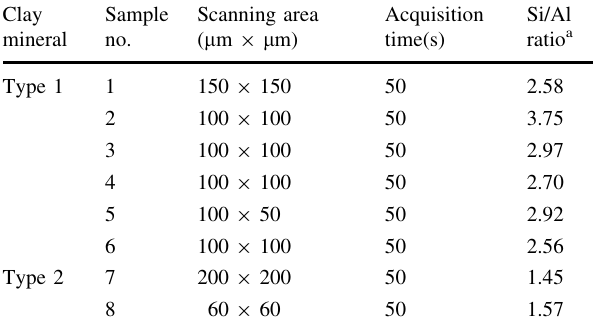
Table 2 Si/Al ratio of the clay minerals Clay Sample mineral